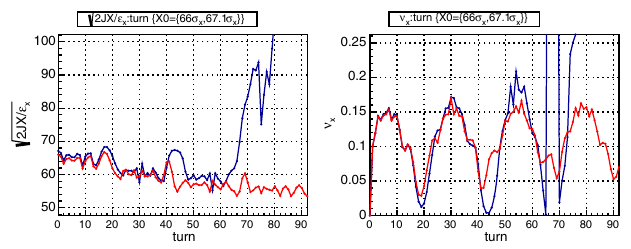
FIG. 5. Phase and time trajectories of the first unstable particle with initial conditions f x ¼ 67 . 1 σ p σ ¼ 0 g